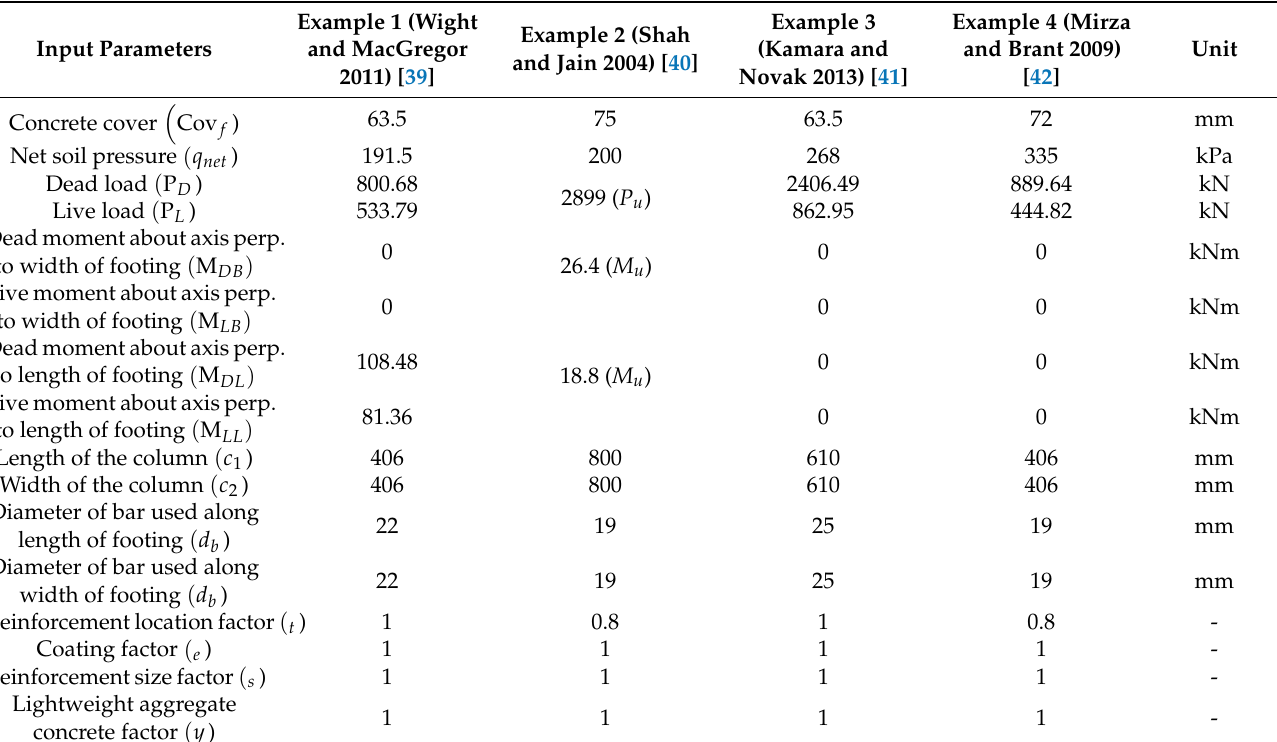
Table 3. Input parameters for Examples